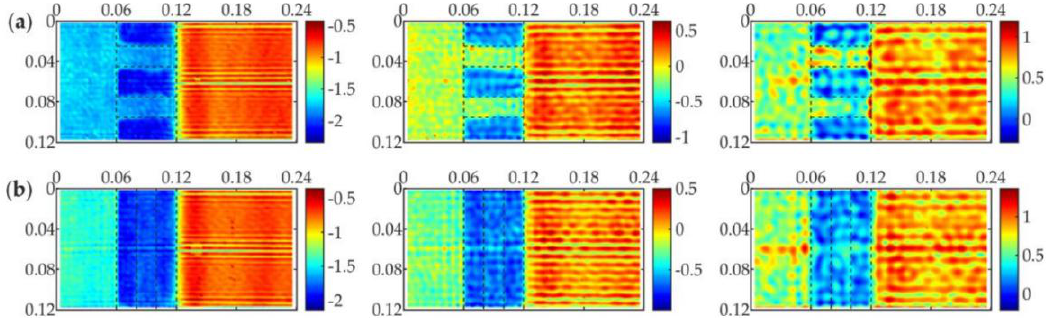
Figure 13. WRMS maps (values in (m/s)) with square weighting factor ( w r = r 2 ), time window T = 3.00 ms and with different excitation frequencies f = 200 kHz (first column), f = 100 kHz (second column), f = 50 kHz (third column): ( a ) specimen #6; and, ( b ) specimen